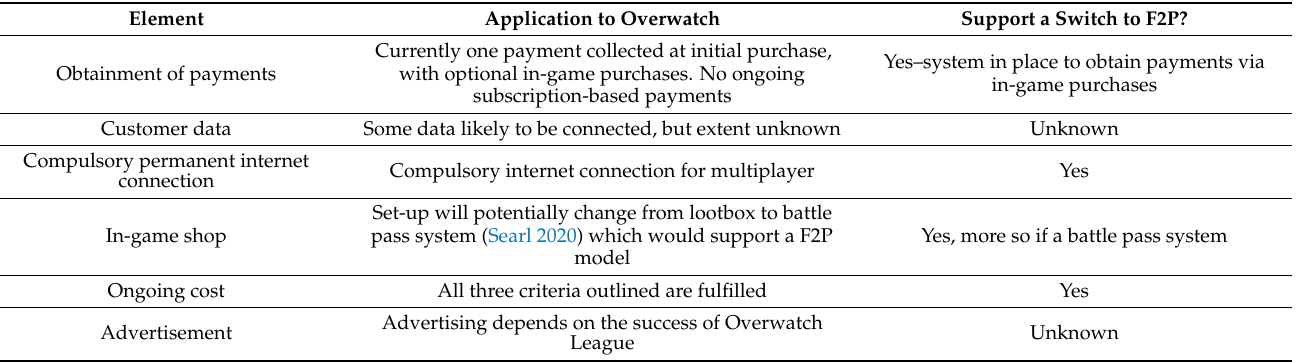
Table 1. Application of Massarczyk et al. (2019) to